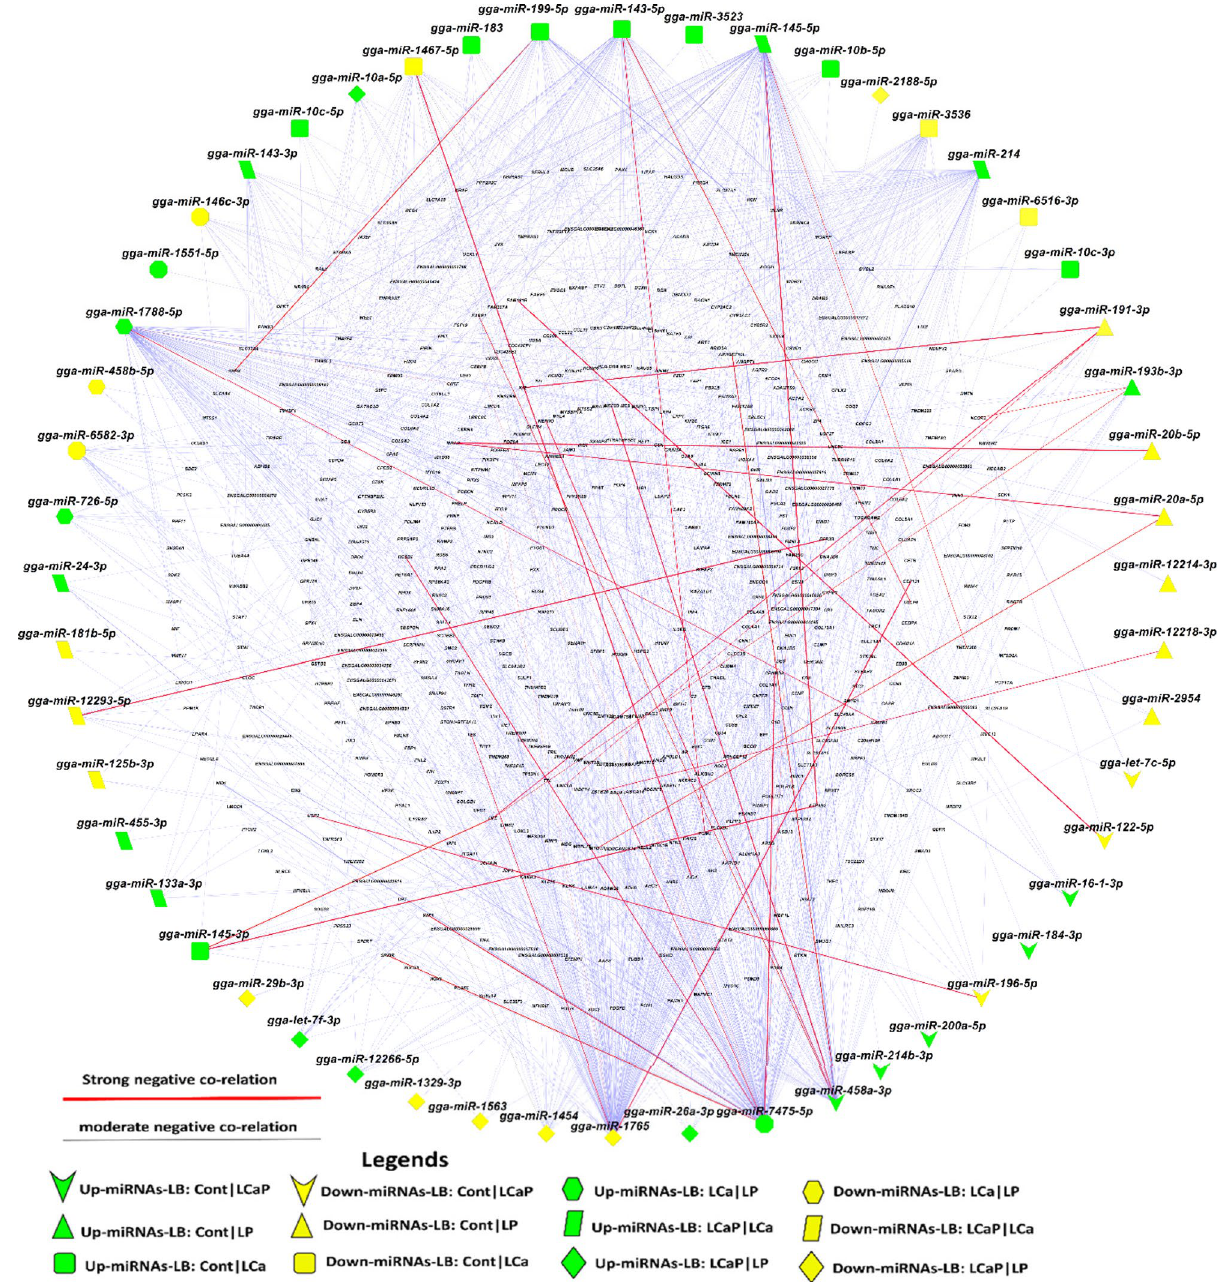
Figure 4. Correlation network analysis of differentially expressed (DE) known miRNAs and their DE target genes from pairwise comparisons between diet groups within LB strain. Correlation network was generated by using MetScape (version 3.1.3) plugin in Cytoscape (version 3.6.1) environment. The mRNAs with negative correlation with miRNAs were considered significant. Green color indicates the upregulated miRNAs and yellow color indicates downregulated miRNAs. Red bold line indicates the strong negative correlation ranging from − 0.35 to − 0.80 and blue line indicates moderate negative correlation ranging from − 0.30 to − 0.35 according to their correlation coefficient